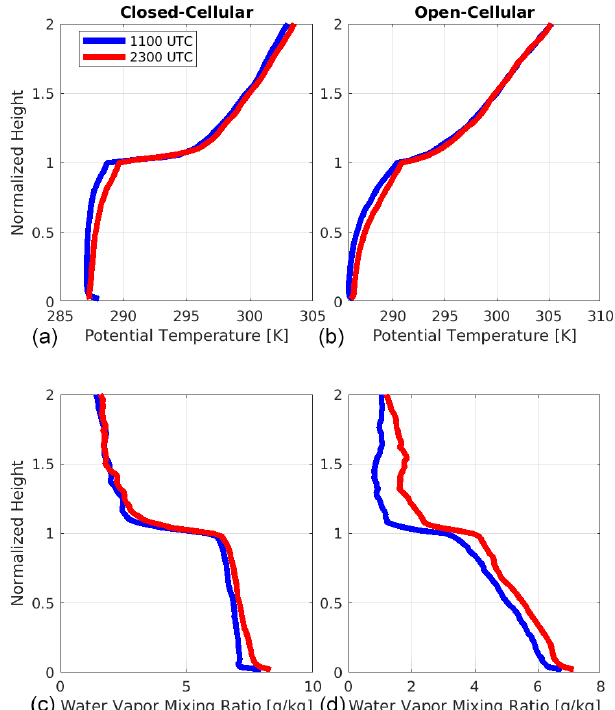
Figure 5. Composite profiles of radiosonde reported (a) poten- tial temperature (K), (b) water vapor mixing ratio (gkg − 1 ), and (c) zonal and (d) meridional wind speed (ms − 1 ) for closed- (blue) and open-cellular (red) cloud populations. The height coordinate is normalized by the boundary layer depth.